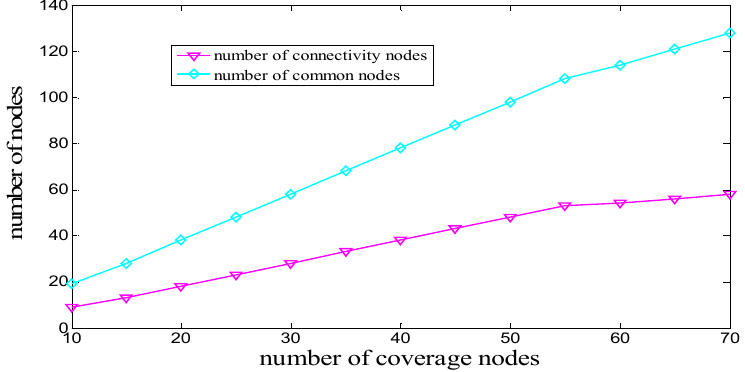
Figure 5. Comparison of the number of various nodes in the GFCND algorithm.